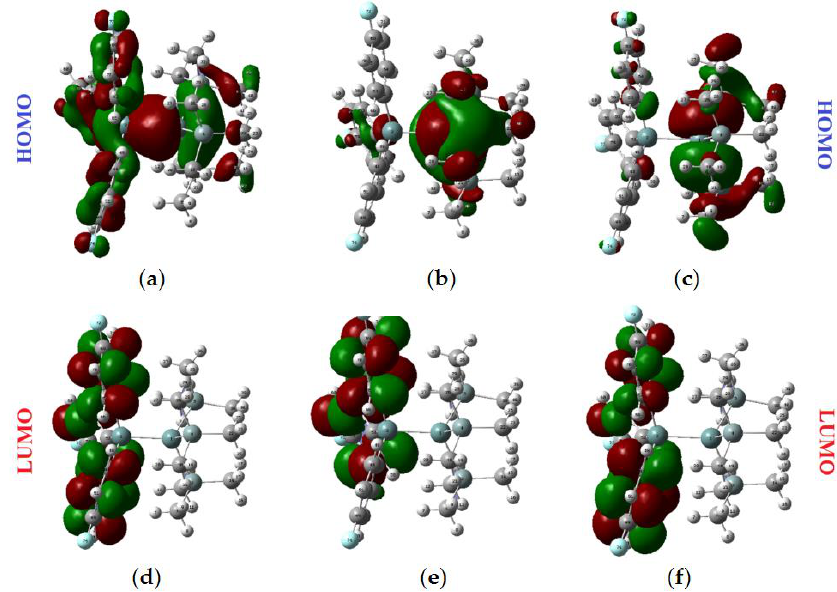
Figure 3. Graphical representation of the frontier orbitals of (Me 3 Si) 3 Ge-Ge(C 6 H 4 F- p ) 3 ( 2 ): ( a ) HOMO; ( b ) HOMO-1; ( c ) HOMO-2; ( d ) LUMO; ( e ) LUMO+1; ( f ) LUMO+2. Theoretical analysis of UV/vis absorption spectral data for (Me 3 Si) 3 Ge-GeAr 3 (Table 1) shows a good correlation with the experiment (see Table 2 below). Table 1. Data of DFT calculations for compounds of the type of (Me 3 Si) 3 Ge-GeAr 3. Compound